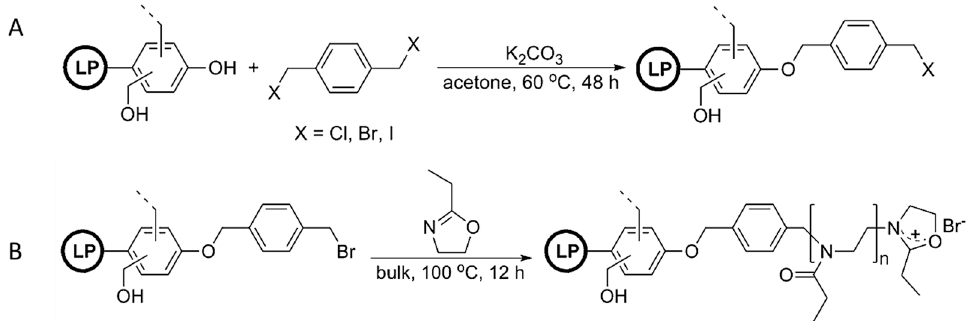
Figure 26. ( A ) Modification of organosoluble lignophenol with α , α′ -dihalo- p -xylene; ( B ) Cationic ring-opening polymerization of 2-ethyl-2-oxazoline. Reproduced with permission [91].